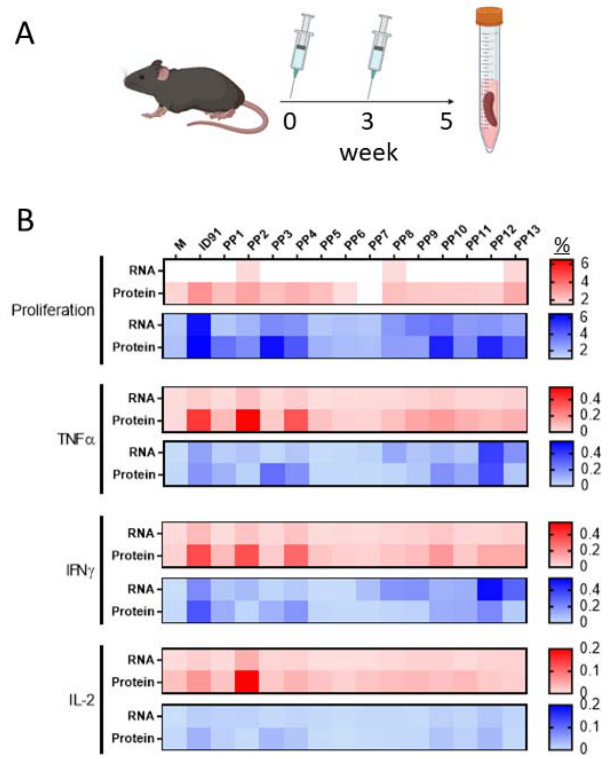
Figure 2. Epitope mapping of T-cell responses with different vaccine platforms. ( A ) Vaccination scheme. C57BL/6 mice were immunized twice, three weeks apart, with ID91 repRNA + NLC (RNA) or ID91 + GLA-SE. ( B ) Two weeks post-boost, splenocytes were stimulated with media (M) whole antigen (ID91) or 13 different peptide pools (PP) with overlapping 15 mers of ID91. Proliferation and cytokine expression were measured by flow cytometry after stimulation. Heat map depicts the percentage of CD4+ (red)- or CD8+ (blue)-responding T cells from each immunization depicted to the left (RNA or Protein). Data representative of a single experiment with n = 4 animals per group.